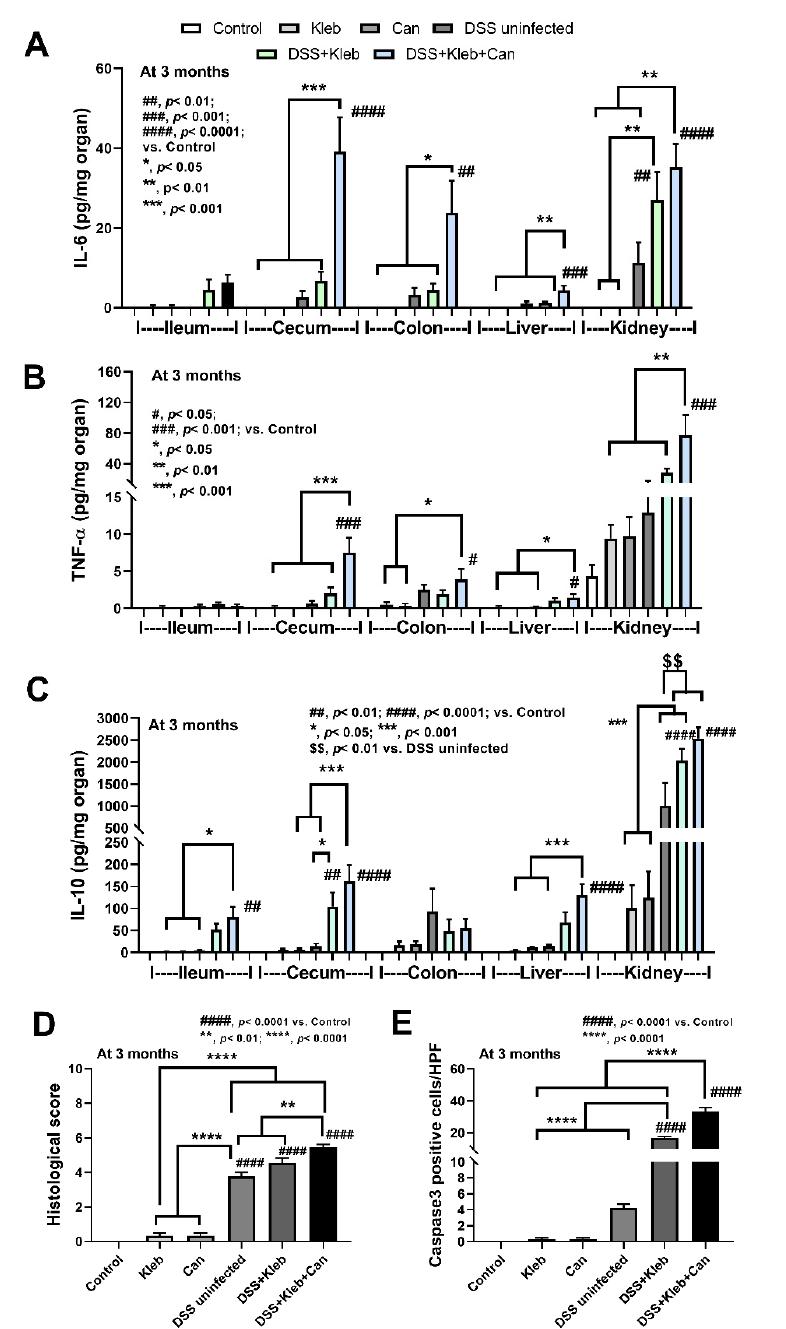
Figure 2. The characteristics of mice after daily gavage with phosphate buffer solution (control), K. pneumoniae (Kleb), or C. albicans (Can) with or without dextran sulfate solution (DSS) as indicated by the cytokines (IL-6, TNF- α , and IL-10) from the intestines (ileum, caecum, and colon), livers, and kidneys ( A – C ), liver histological scores and caspase 3 positive cell ( D , E ). (n = 8–10/group). #, p < 0.05; ##, p < 0.01; ###, p < 0.001; ####, p < 0.0001 vs. control; $$, p < 0.01 vs. DSS uninfected; *, p < 0.05; **, p < 0.01; ***, p < 0.001, the indicated groups as have determined by ANOVA with Tukey’s analysis.